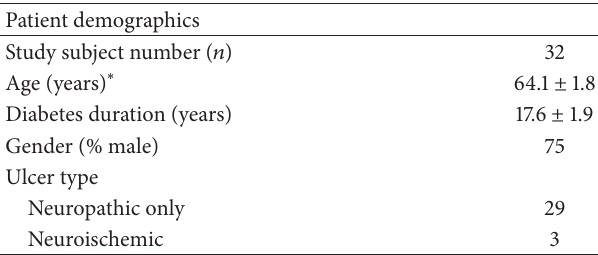
Table 3: Demographics of patients with diabetes who had postde- bridement foot ulcer fluid